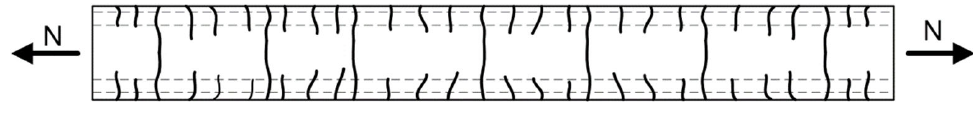
Figure 5. Macrocracks due to tension; N -axial force.